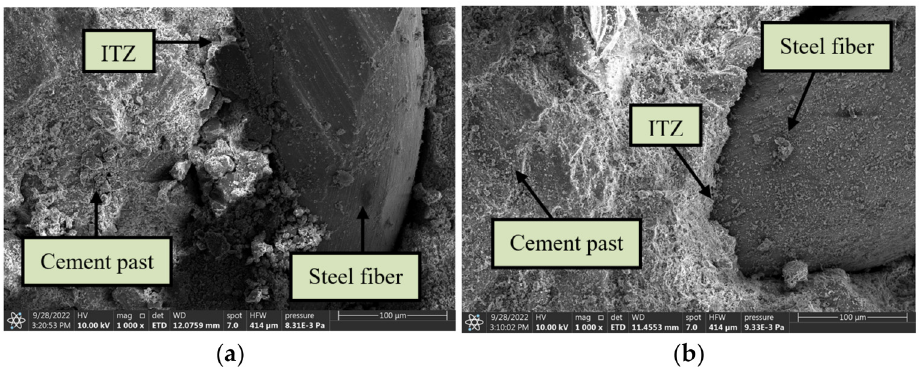
Figure 17. Microstructure of ITZ between fiber and cement paste: ( a ) R100-H1.0; ( b )